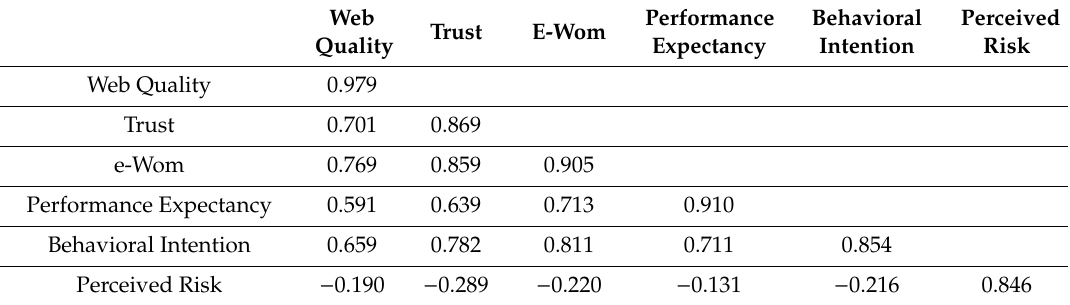
Table 4. Discriminant validity (Fornell–Larcker Test).